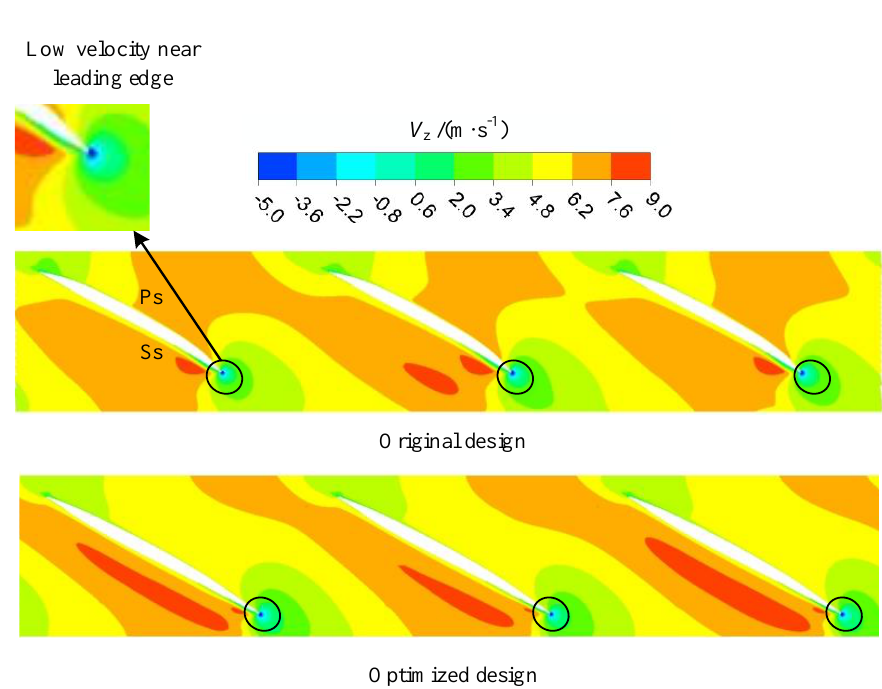
Figure 16. Comparison of the velocity distribution in the impeller between the original design and optimized design under the reverse design flow rate (span = 0.5).